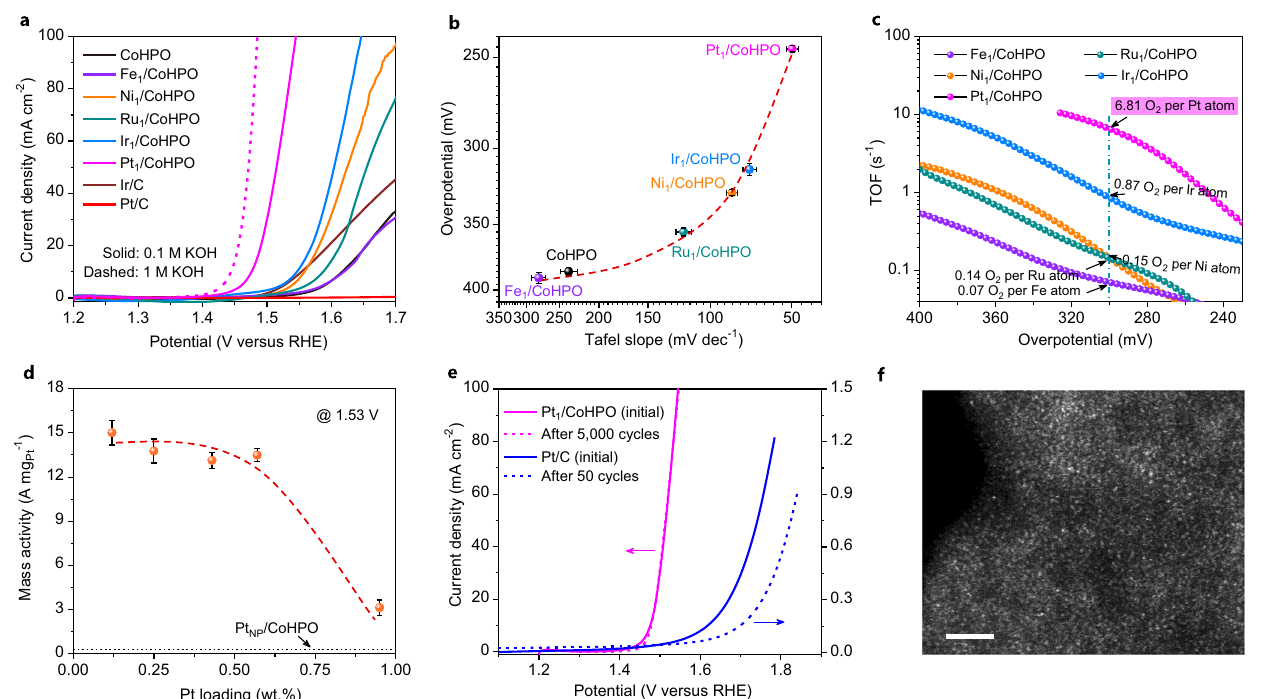
Fig. 2 Electrochemical OER performance. a Polarization curves of CoHPO and different M 1 /CoHPO catalysts tested in 0.1 M and 1 M KOH solutions. Reference samples of Ir/C and Pt/C are also included for comparison. b OER data analysis of overpotentials (obtained from the polarization curves at 10 mA cm − 2 current density) and Tafel slopes in 0.1 M KOH. c TOFs curves of different M 1 /CoHPO catalysts based on the loading amounts of metals at different overpotentials. d Mass activities of Pt 1 /CoHPO with different Pt loadings at 1.53 V vs . RHE. e The polarization curves of Pt 1 /CoHPO and Pt/C before and after 5000 (for Pt 1 /CoHPO) and 50 (for Pt/C) potential cycles tested in 0.1 M KOH. f A high-resolution HAADF-STEM image of Pt 1 /CoHPO after the durability test, in which the bright contrast spots present the Pt single atoms. Scale bar, 2 nm. Error bars in b , d represent the average values (mean ± s.d., n =